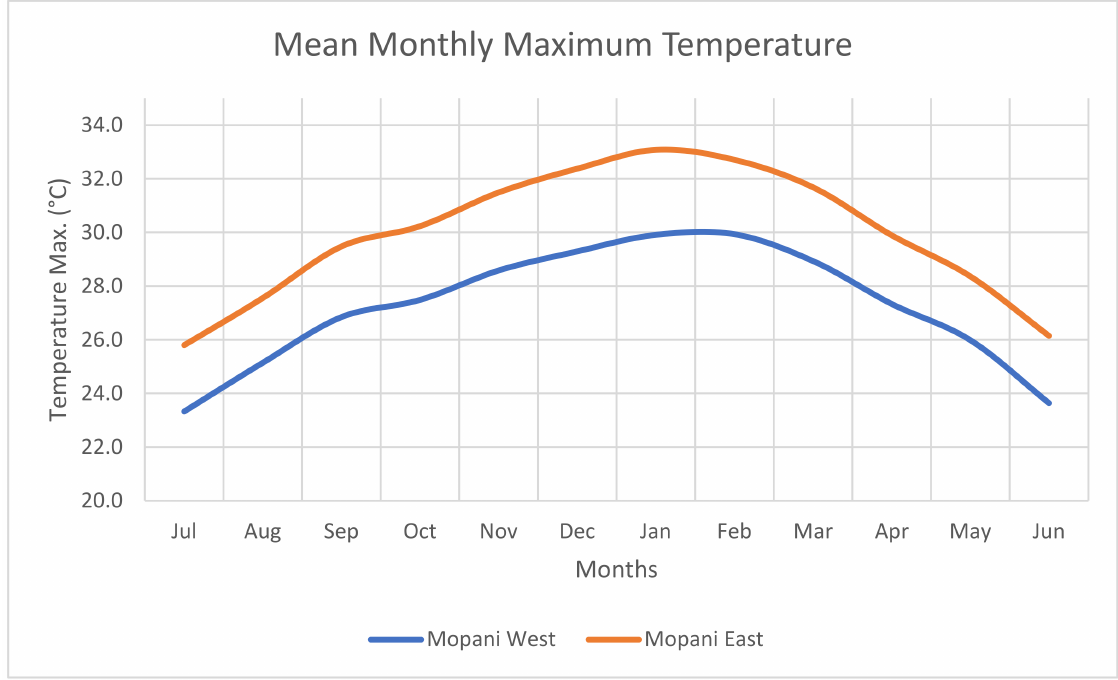
Figure 4. Mean annual cycle of maximum temperature for Mopani bushveld (west) and the lowveld (east), calculated from a 1980–2016